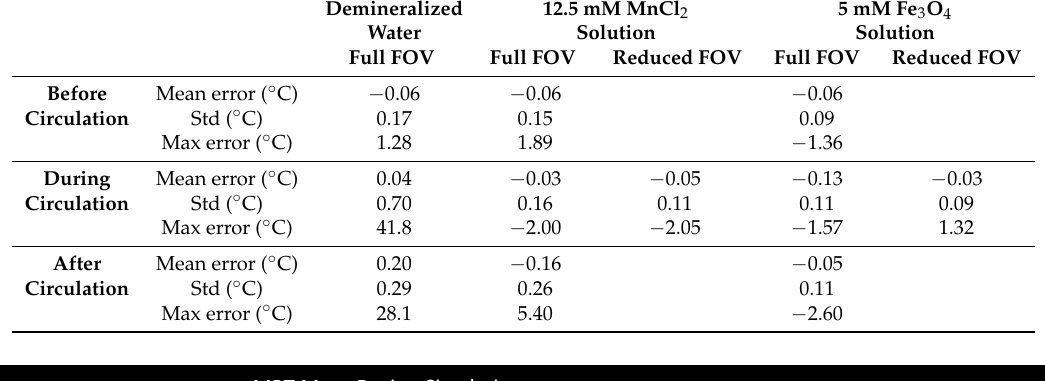
Table 2. Mean, standard deviation and maximum temperature errors before water circulation, during water circulation, after water circulation when demineralized water, 12.5 mM MnCl 2 solution, and 5 mM Fe 3 O 4 solution is used in the WB.